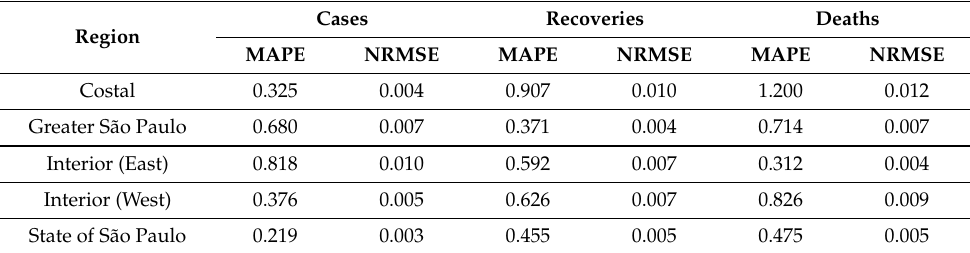
Table 5. Tabulated errors for the predictions depicted in Figure 11 (São Paulo state regions).